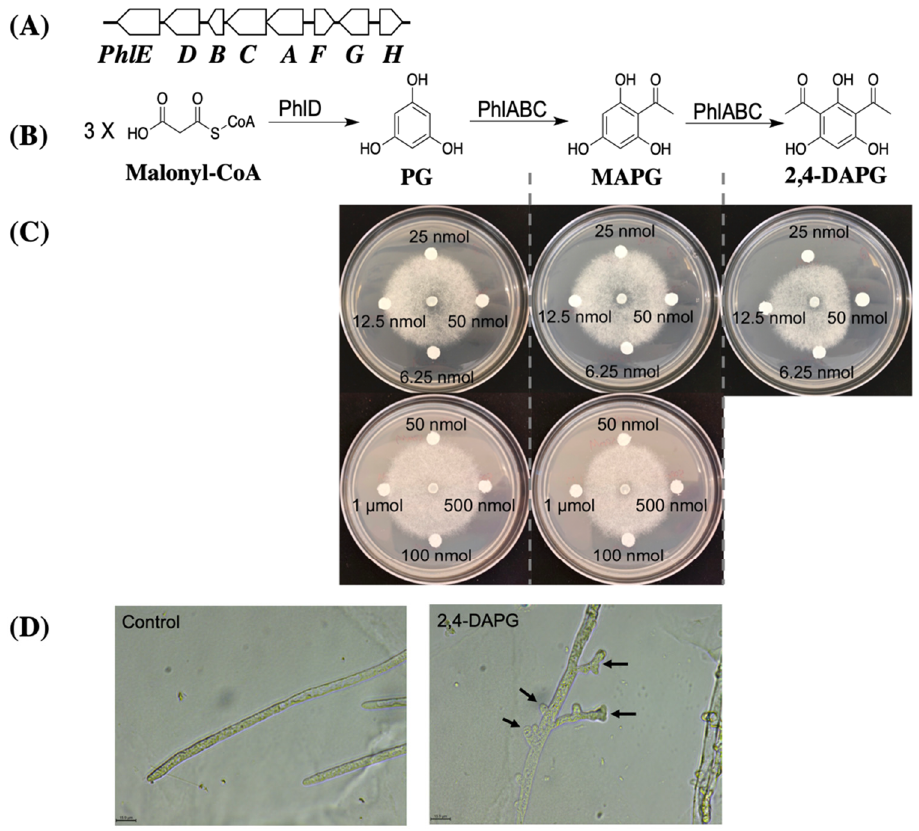
Figure 3. Impact of metabolites generated in the 2,4-DAPG biosynthesis pathway on hyphal growth of A. euteiches . ( A ), 2,4-DAPG gene cluster of Pf-5. Genes phlABCD encode four enzymes (PhlABCD) in the 2,4-DAPG biosynthesis pathway ( B ), and their expression is negatively regulated by the transcriptional repressor PhlF; PhlG degrades 2,4-DAPG to MAPG and its expression is controlled by PhlH; phlE encodes a putative permease of 2,4-DAPG. ( C ), Filter paper disks containing the indicated amount of the tested compounds were dried and placed around A. euteiches on ½ PDA plates. Representative results from three replicates were recorded two days after inoculation. ( D ), the oomycete hyphae were sampled at the A. euteiches growth margin on plates of ( C ) and examined under a microscope immediately after the inhibition was observed. Control indicates no compound treatment. Arrows show the excessive hyphal branching and stunted branches. Size bars indicate 15.9 μ m. The experiments were repeated at least two times.